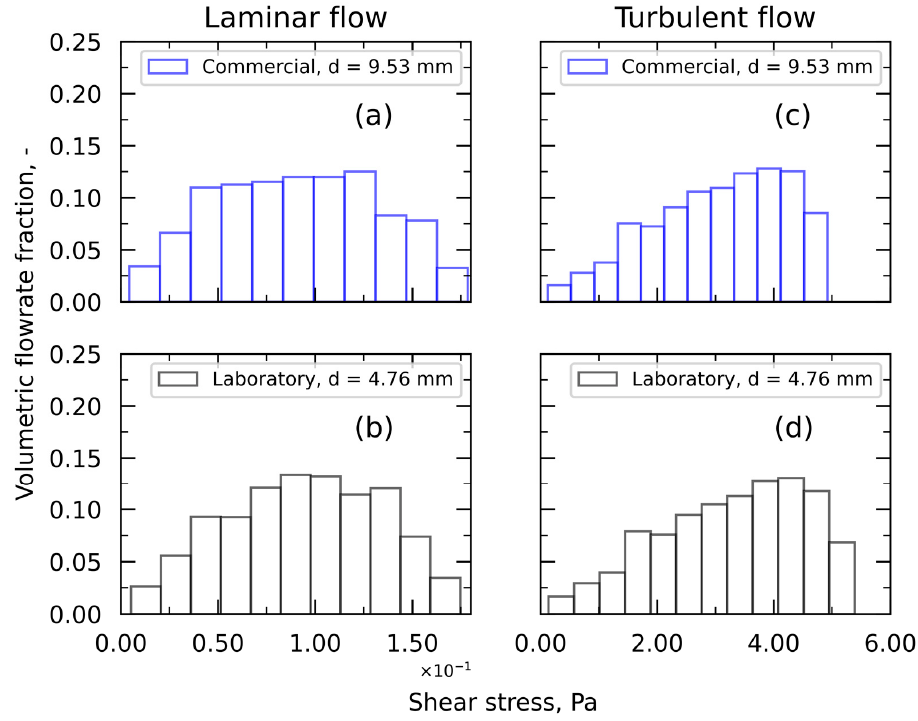
Figure 9. Shear stress distribution weighted on normalized volumetric flowrate following application of Approach 3 under laminar ( a , b ) and turbulent conditions ( c , d ) for the commercial ( a , c ) and laboratory scales ( b , d ), respectively.